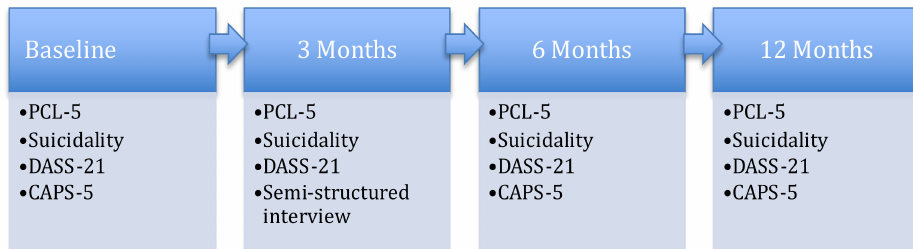
Figure 1. Assessment Timings. Note. PCL-5 = PTSD Checklist. Suicidality = four questions related to suicidal ideation, plans, and behaviours. DASS-21 = Depression Anxiety and Stress Scale—Short Form. CAPS-5 = Clinician-Administered PTSD Scale for